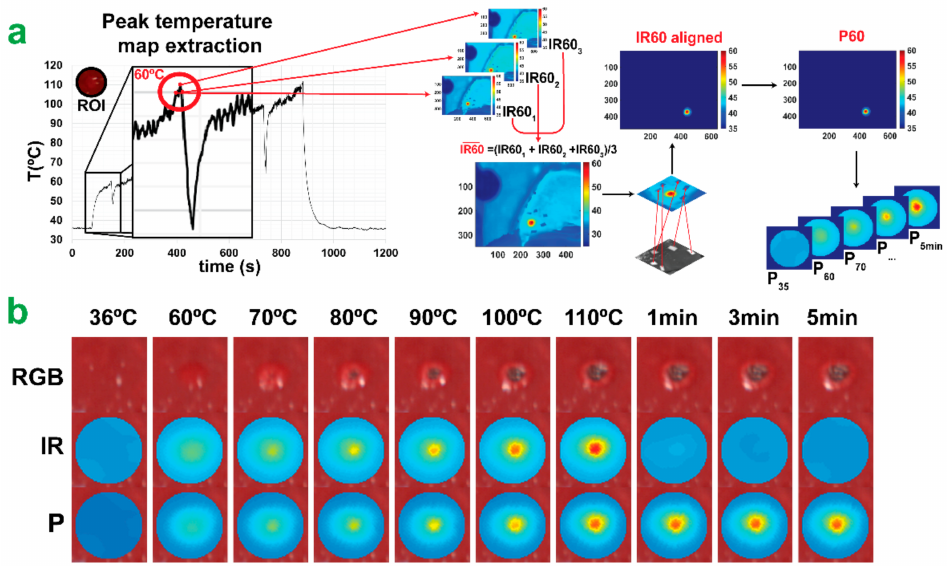
Figure 4. Peak temperature map extraction. ( a ) PTPM dataset creation. Extraction of peak tempera- ture maps (P i ) from IR camera video. ( b ) The normal RGB is reported with IR i , aligned and P i images for each acquisition